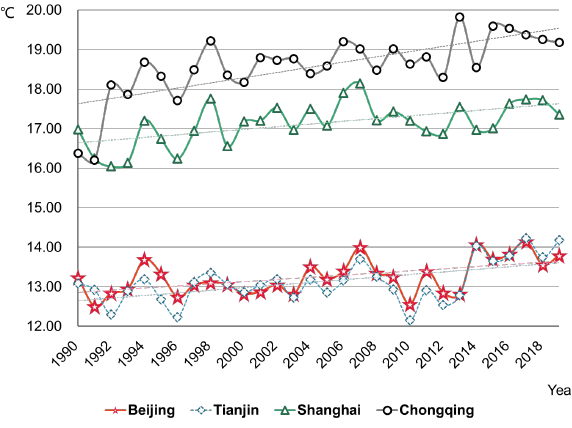
Figure 6 . Average temperature change from 1990 to 2019. Chongqing has the highest temperature and the fastest rising speed, which changed from 16.38°C at the beginning to 19.18°C at the end. However, its warming situation has improved after 2015, and the temperature has continued to drop for 5